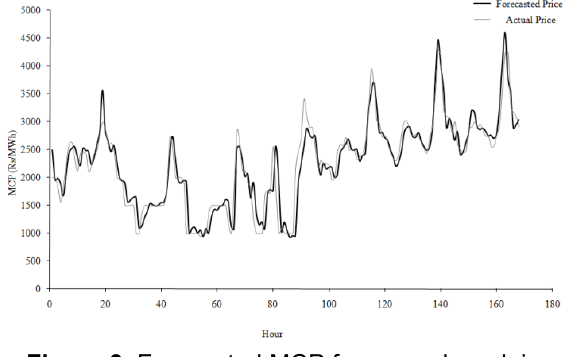
Figure 13 . Forecasted MCP for a fall week (Austrian market in the year